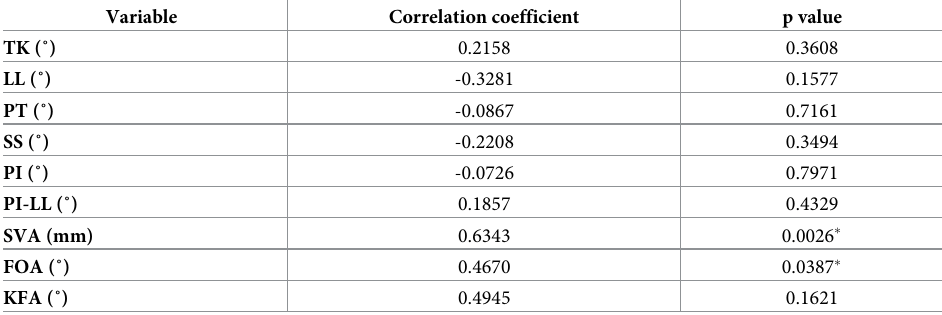
Table 2. Spearman’s rank correlation coefficients of the HCF with patients’ sagittal alignment